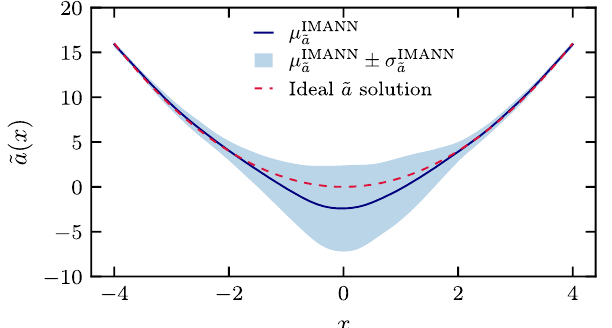
Figure 9. Mean prediction µ ˜ a of a ˜ a subfunction made by IMANN with indicated one standard deviation σ ˜ a region.